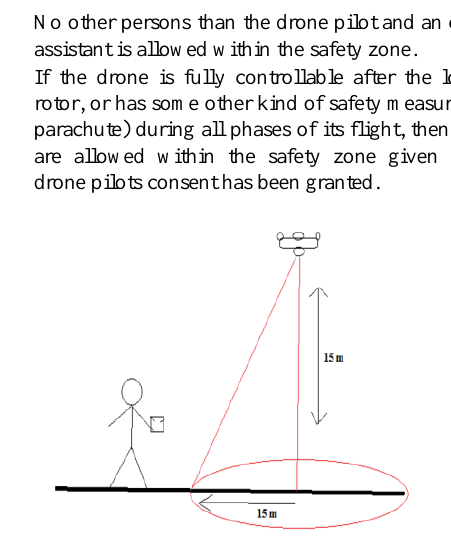
Figure 2. Illustration of drones’ safety